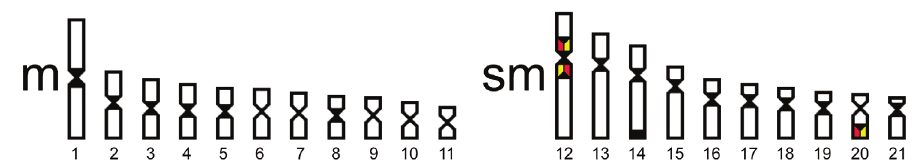
Figure 3. Idiogram referring to the Hoplias malabaricus populations (karyomorph A) from the Ctalamo- chita River, highlighting the chromosome markers. Black: C-positive heterochromatin; red: 18S rDNA sites; yellow: nucleolar organizer regions (NORs). Putative pericentromeric NOR in chromosome pair 12 was also